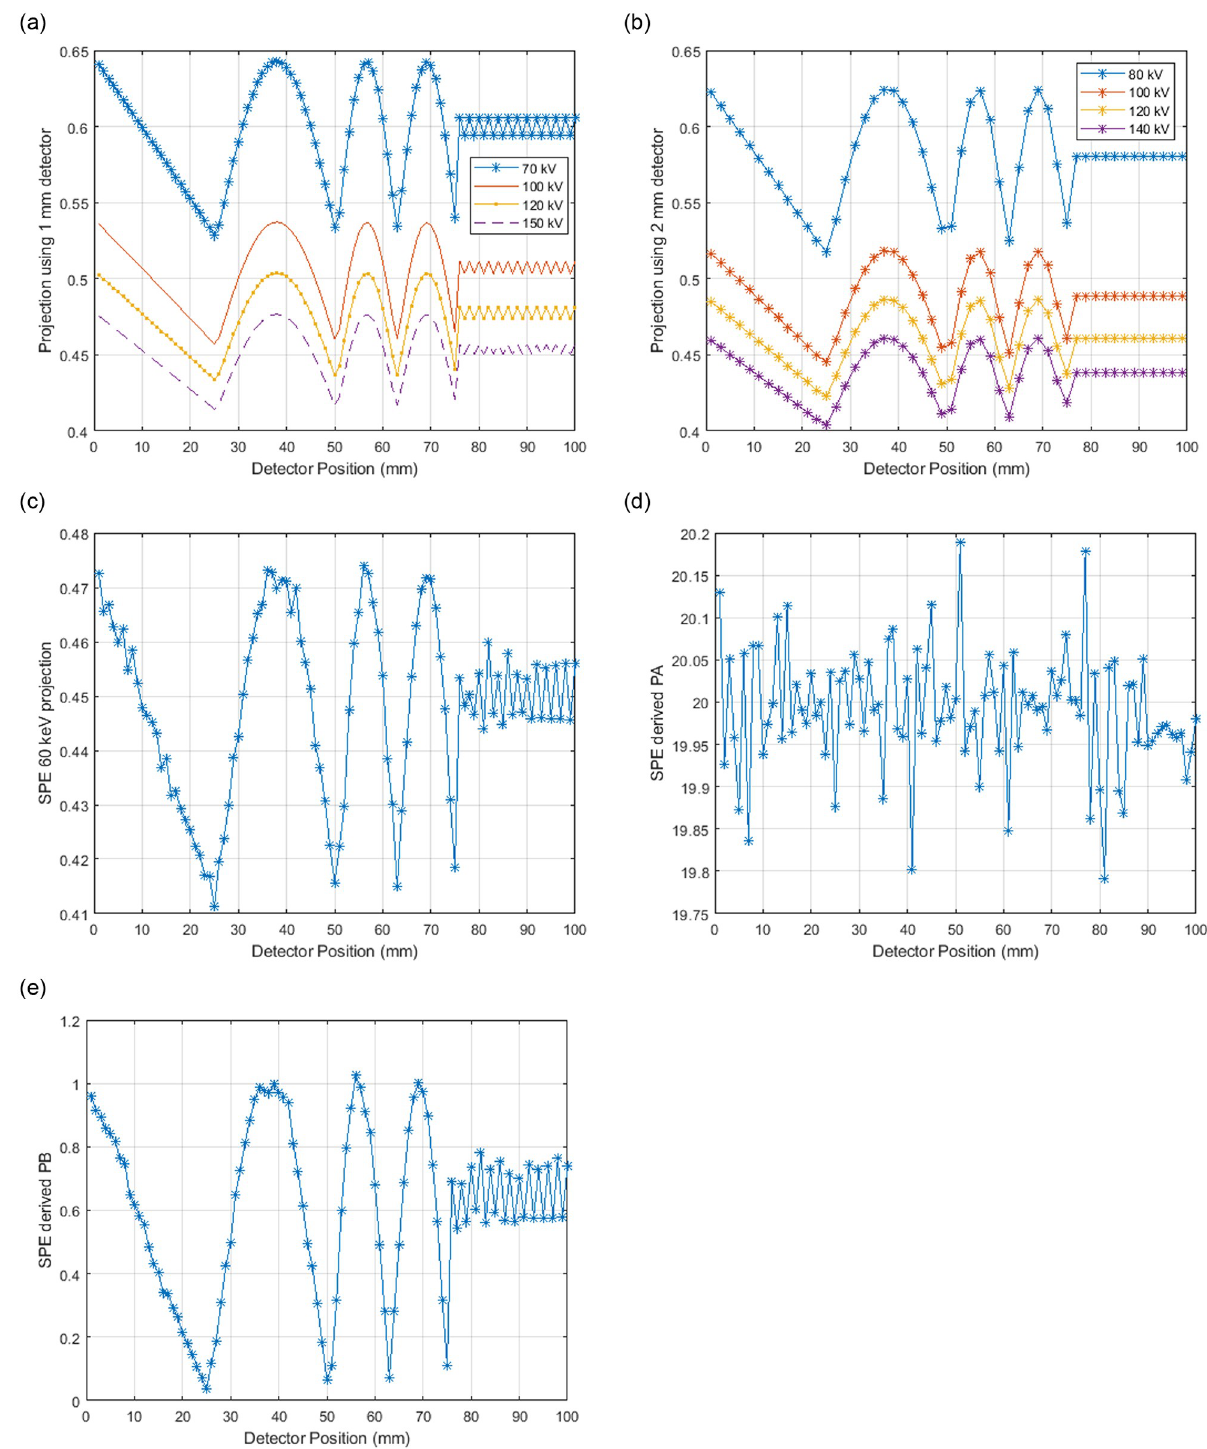
Fig 4. 1 mm detector element line profile are shown in (a), 2 mm detector element line profiles are shown in (b), a SPE derived 60 keV line profile with a synthesized resolution of 1 mm detector elements is shown in (c). (d) is the contribution from PA representing the water contribution and (e) is the contribution from PB representing the bone